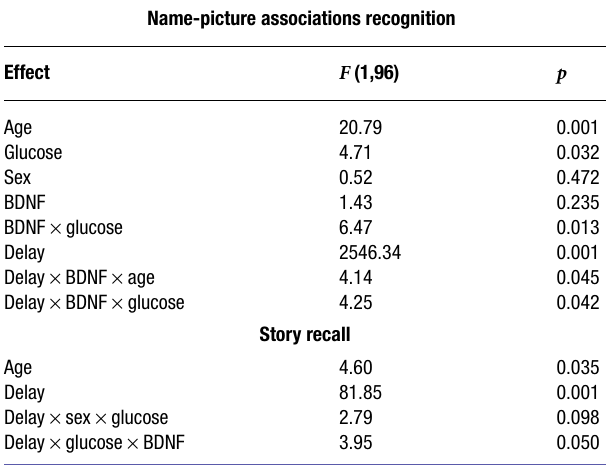
Table 2 | Effects of age, fasting blood glucose, and BDNF Val66Met poly- morphism on episodic